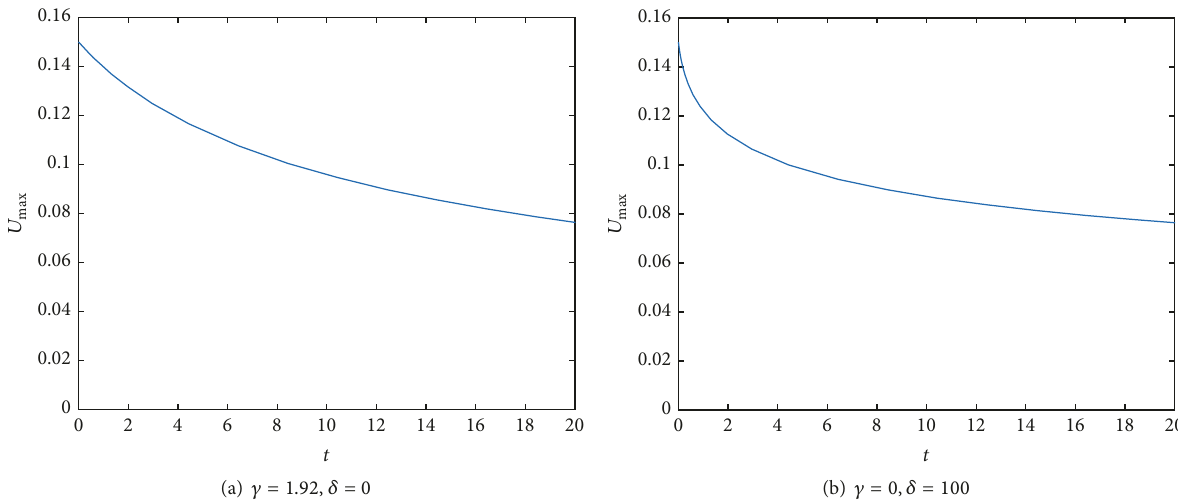
Figure 6: Example 3. The corresponding dissipative term coefficient when 𝑈 max has the same value at the beginning and final time; (a) 𝑈 max of the equation with just one dissipative 𝑢 𝑥𝑥 and the coefficient 𝛾 = 1.92 ; (b) 𝑈 max of the equation with just one dissipative 𝑢 𝑥𝑥𝑥𝑥 and the coefficient 𝛿 = 100